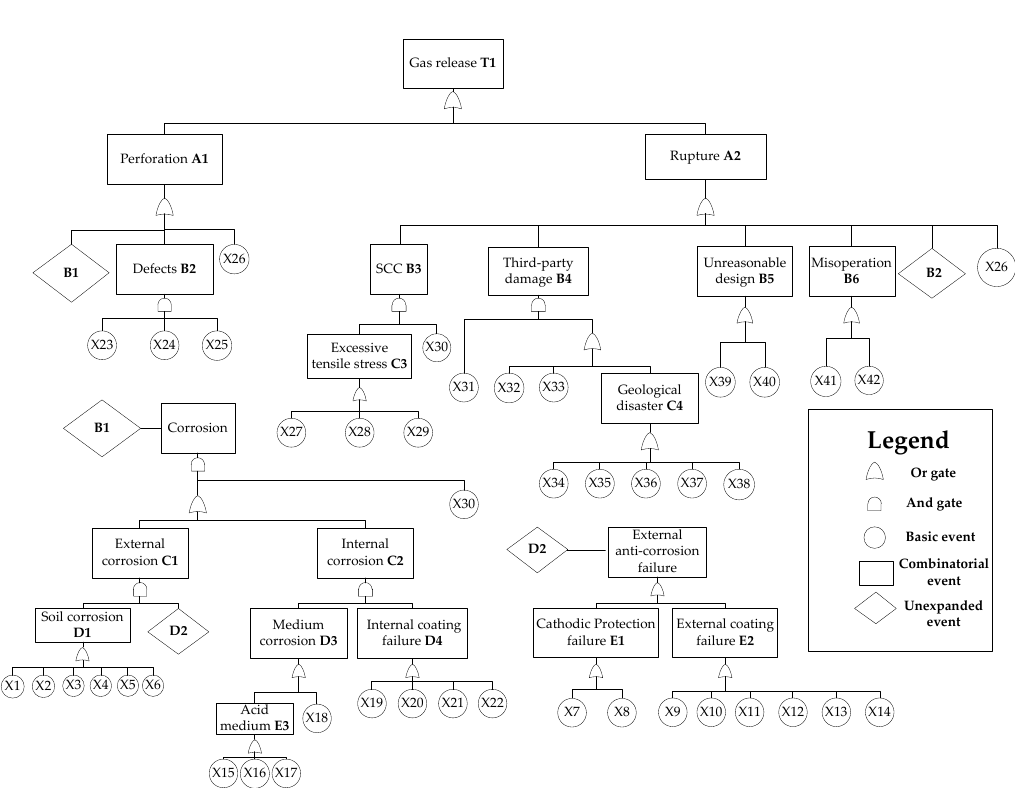
Figure 9. Fault tree of the natural gas pipeline in the same ditch laying system.